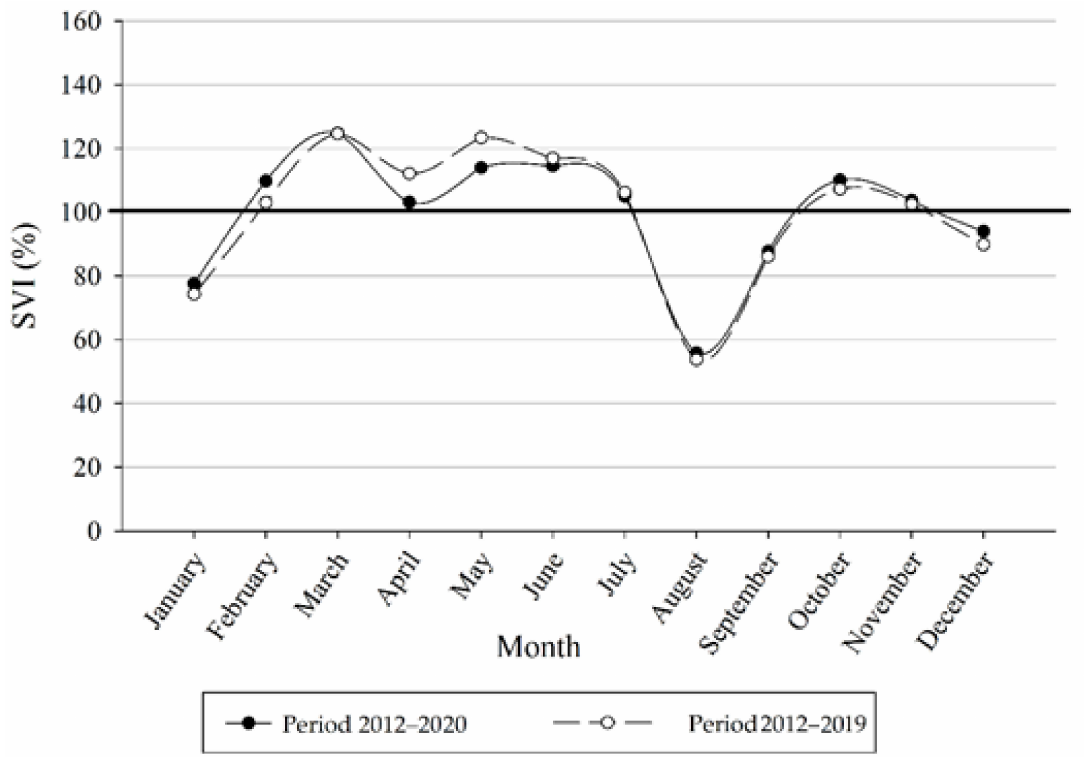
Figure 10. Seasonality pattern of vehicle embarking traffic of the port of Barcelona during the periods 2012–2019 and 2012–2020.